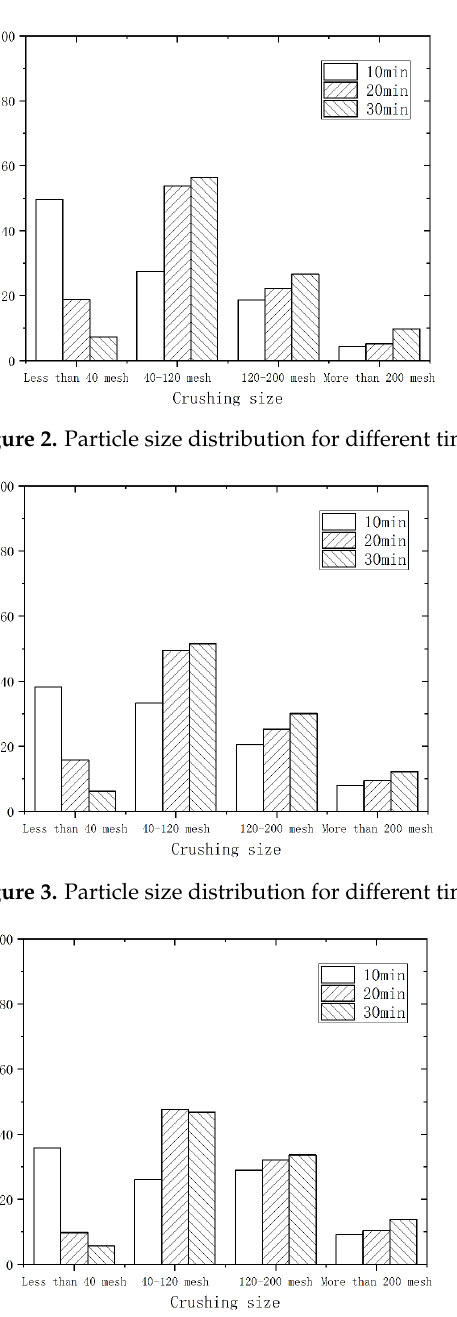
Table 3. Results of the comminution experiment.